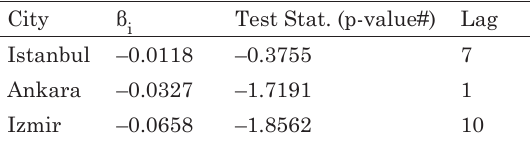
table 2. Univariate augmented dickey-fuller test